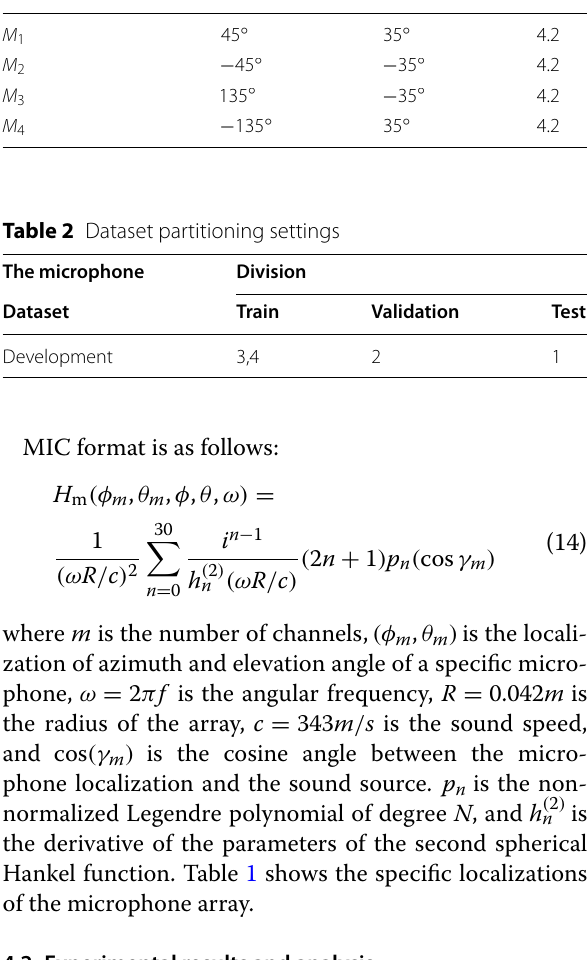
Table 1 Layout table of microphone localizations The microphone